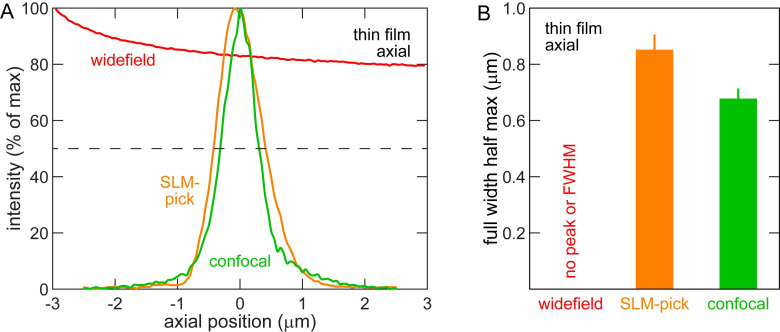
SLM confers sectioning capability of diffuse fluorescent source.(A) Intensity of light at axial positions around fluorescent thin film at z = 0. Dotted line at 50% maximum intensity. (B) FWHM of data in (A). n = 20 locations. Note optical sectioning capability conferred by SLM.